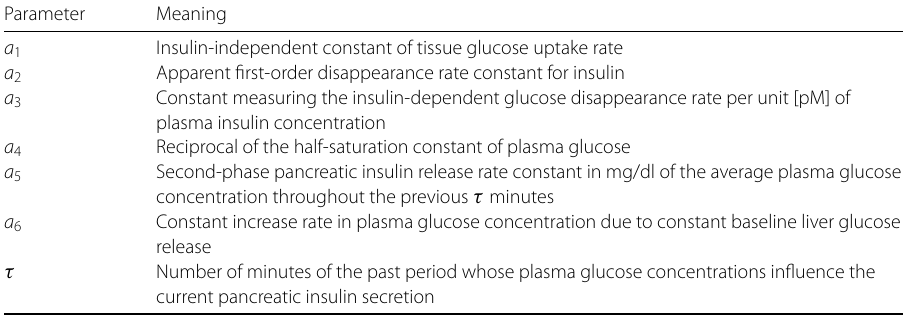
Table 1 Meaning of the parameters used in the model of glucose–insulin interaction in Eq. (3)